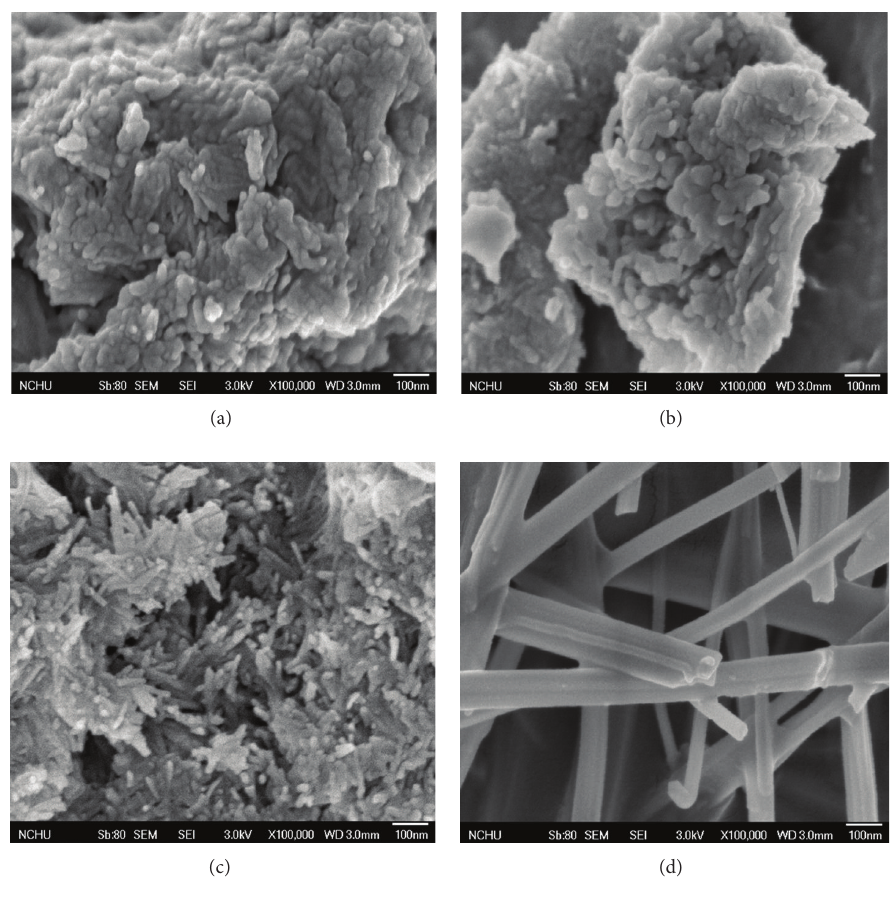
Figure 7: SEM images of the samples prepared at different reaction temperatures: (a) 110 ∘ C, (b) 130 ∘ C, (c) 150 ∘ C, and (d) 180 ∘ C.